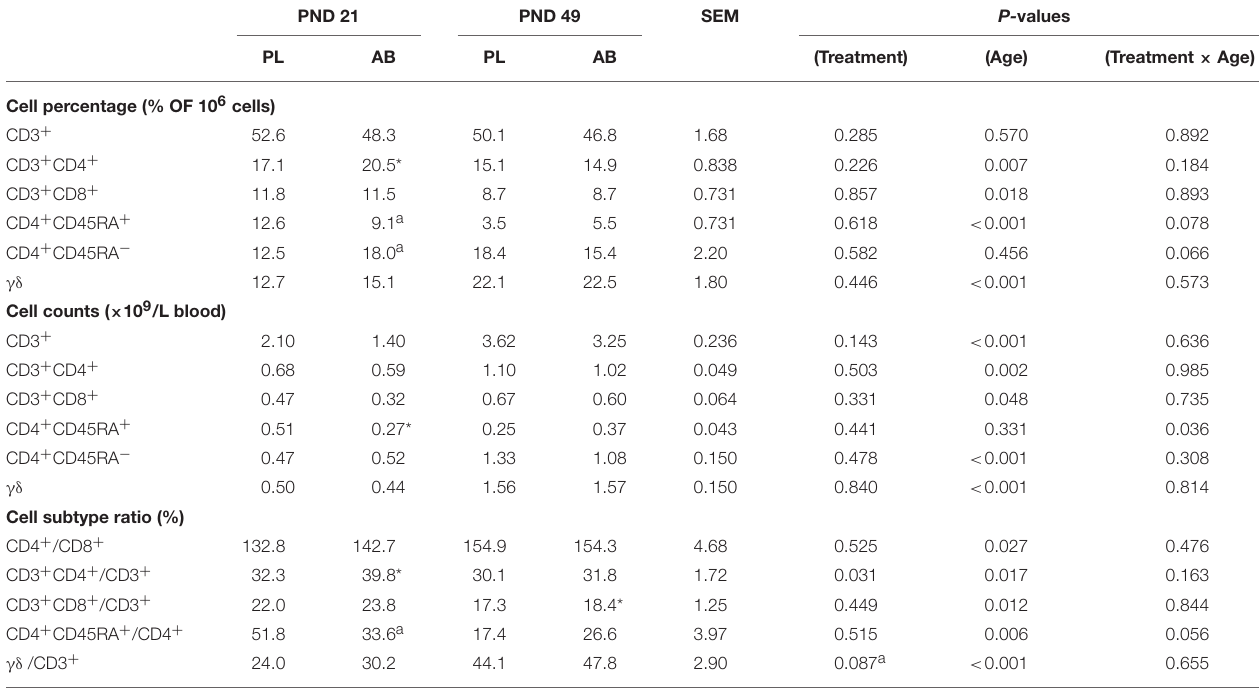
TABLE 1 | Peripheral blood immune cell populations of AB and PL pigs on PND 21 and 49 1 . PND 21 PND 49 SEM P- values PL AB PL AB (Treatment) (Age) (Treatment ×